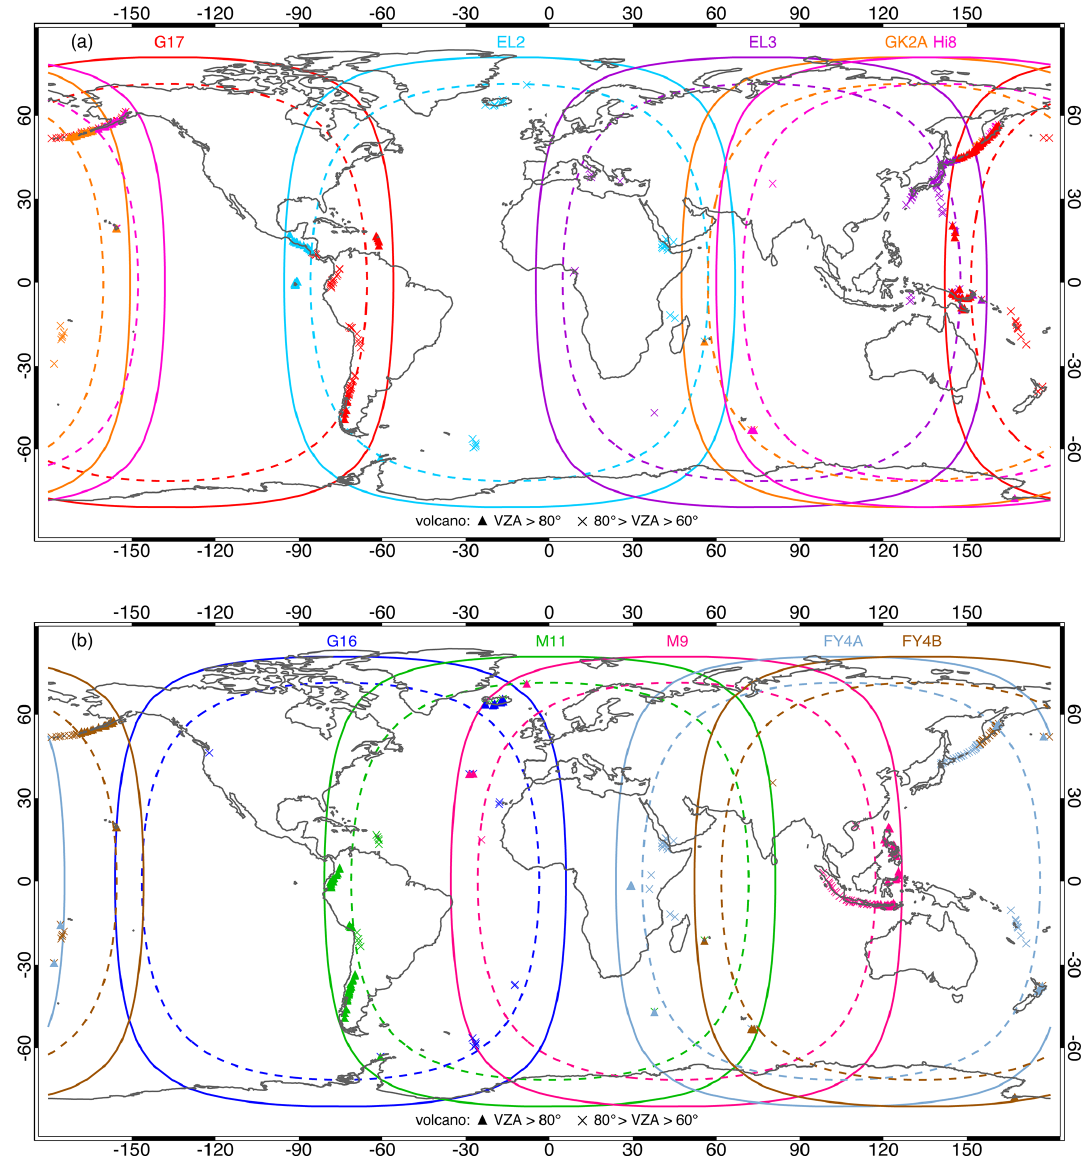
Figure 3. Limb areas of geostationary satellites between a VZA of 80 ◦ (dashed line) and 90 ◦ (solid line): (a) GOES-17 (G17, 137.2 ◦ W), Electro-L N2 (EL2, 14.5 ◦ W), Electro-L N3 (EL3, 76 ◦ E), GEO-KOMPSAT-2A (GK2A, 128.2 ◦ E), Himawari-8 (Hi8, 140.7 ◦ E) and (b) GOES-16 (G16, 75.2 ◦ W), Meteosat-11 (M11, 0 ◦ ), Meteosat-9 (M9, 45.5 ◦ E), Feng-Yun-4A (FY4A, 104.7 ◦ E), Feng-Yun-4B (FY4B, 133 ◦ E). INSAT-3D (82 ◦ E) is not shown; its coverage is similar to that of EL3. Triangles indicate volcanoes that erupted within the limb areas in the past 100 years. Similarly, crosses indicate volcanoes imaged under a relaxed constraint of 80 ◦ > VZA > 60 ◦